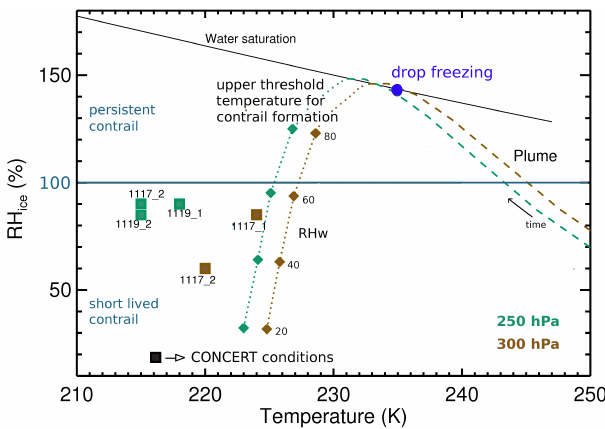
Fig. 1. Ambient temperature and humidity conditions during four CONCERT flights (rectangles, colored by pressure, labeled with mmdd flightnumber) and calculated upper threshold temperatures for contrail formation for the same pressures and varying RH w (rel- ative humidity wrt water; dotted lines with diamonds): the contrail formation criterion was well fulfilled during the flights. Dashed lines: calculated evolution of aircraft plume temperatures and RH ice until drop formation and freezing for the two mean ambient pres- sures.